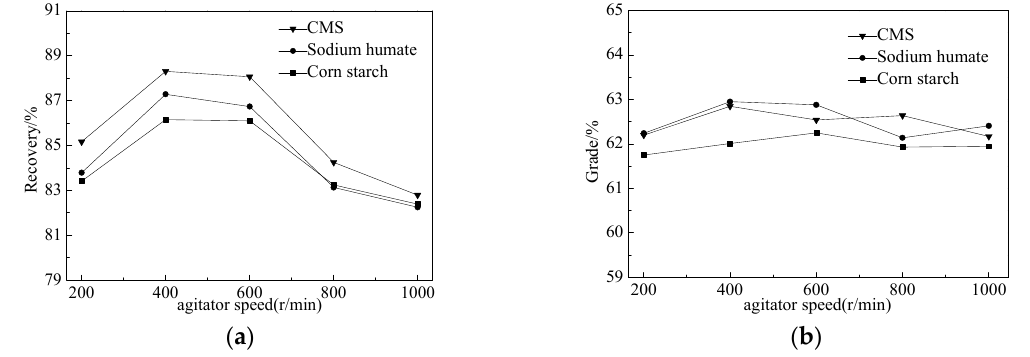
Figure 10. The effects of agitator speed on concentrate. ( a ) Iron recovery; ( b ) Iron grades.